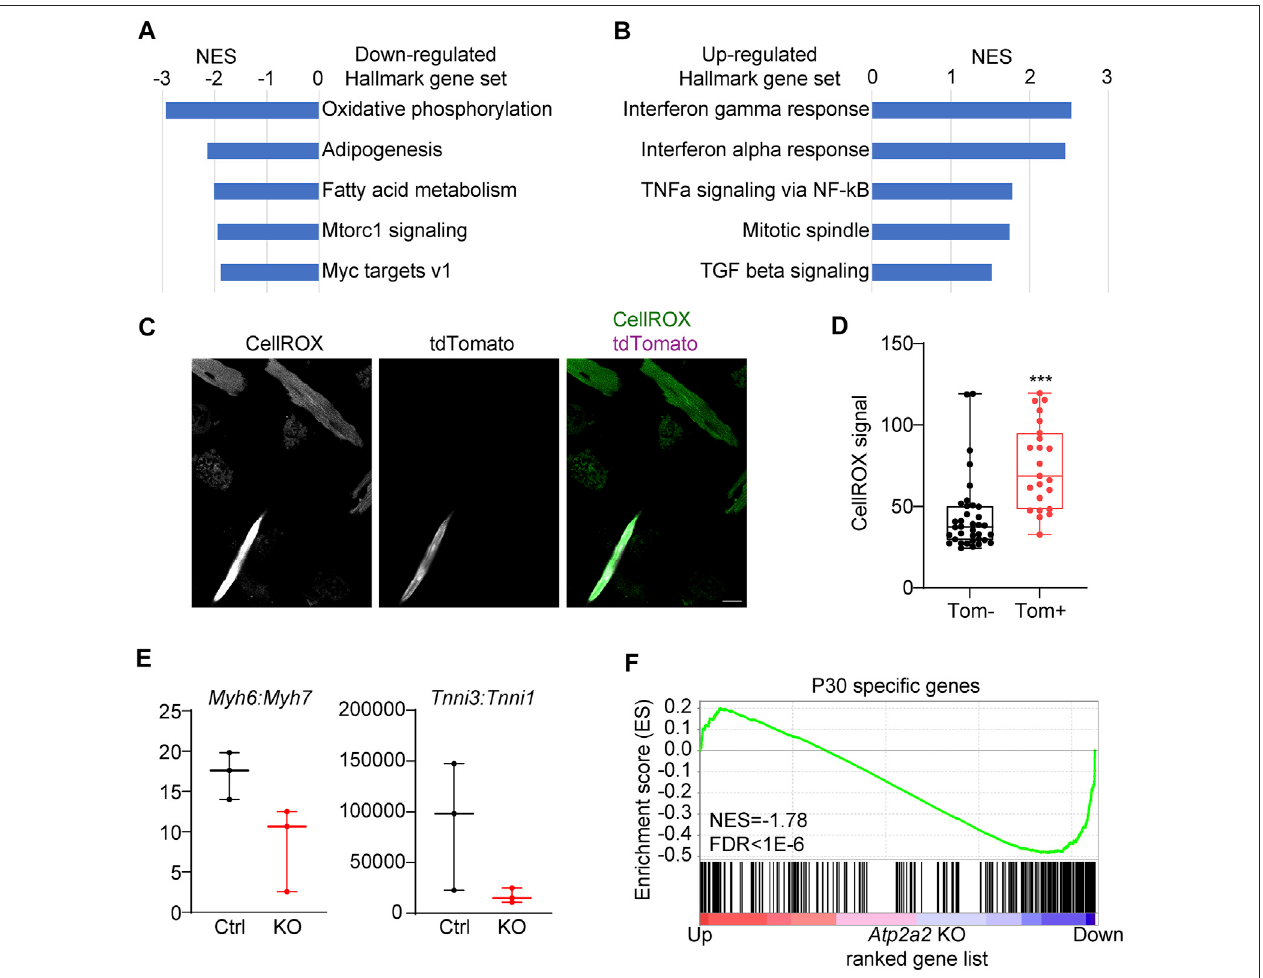
FIGURE 7 | Transcriptomic maturation defects in Atp2a2-deleted cardiomyocytes. (A-B) , GSEA of the top dysregulated Hallmark gene sets in Atp2a2 -deleted cardiomyocytes. (C-D), CellRox stainingand quanti fi cation ofROSinisolatedcardiomyocytes.Scale bar,20 μ m.Unpaired two-tailedstudent ’ st-test: *** p < 0.001. (E) , RPKM ratio analysis of Myh6-7 and Tnni3-1 isoform switching. (F) , GSEA of P30-speci fi c genes in Atp2a2 -deleted cardiomyocytes.